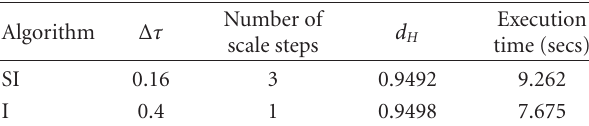
Table 1: Comparisons between two algorithms: E d = O (10 − 1